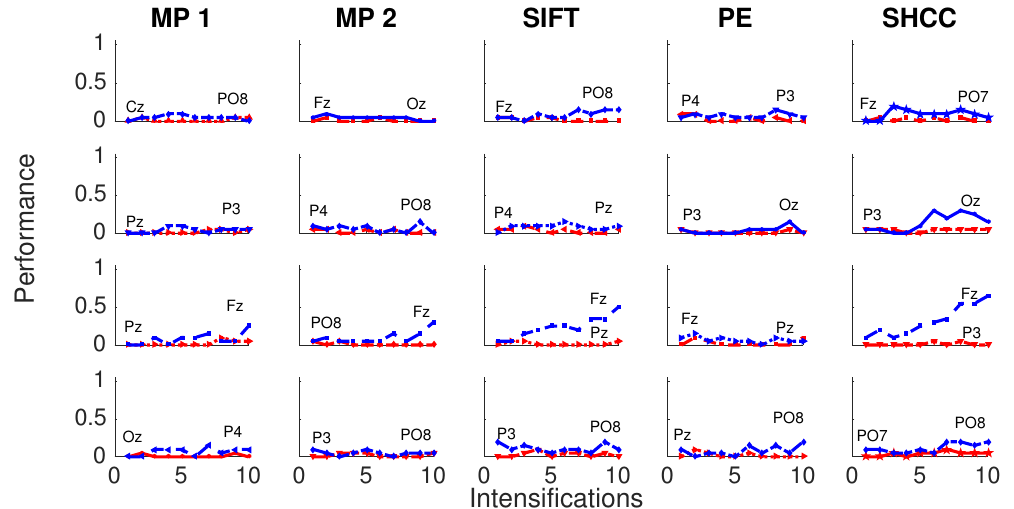
Figure 8. Passive Modality—Experiment 2: Performance curves for four subjects for the five algorithms when a random latency is included when superimposing the P300 signal